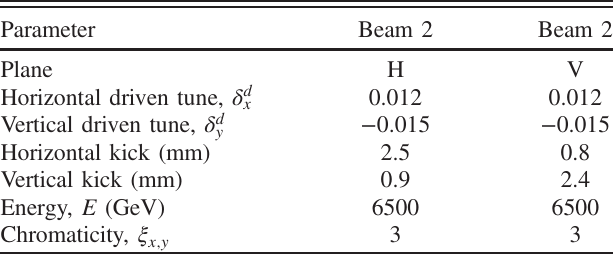
TABLE V. ac dipole and beam parameters for the